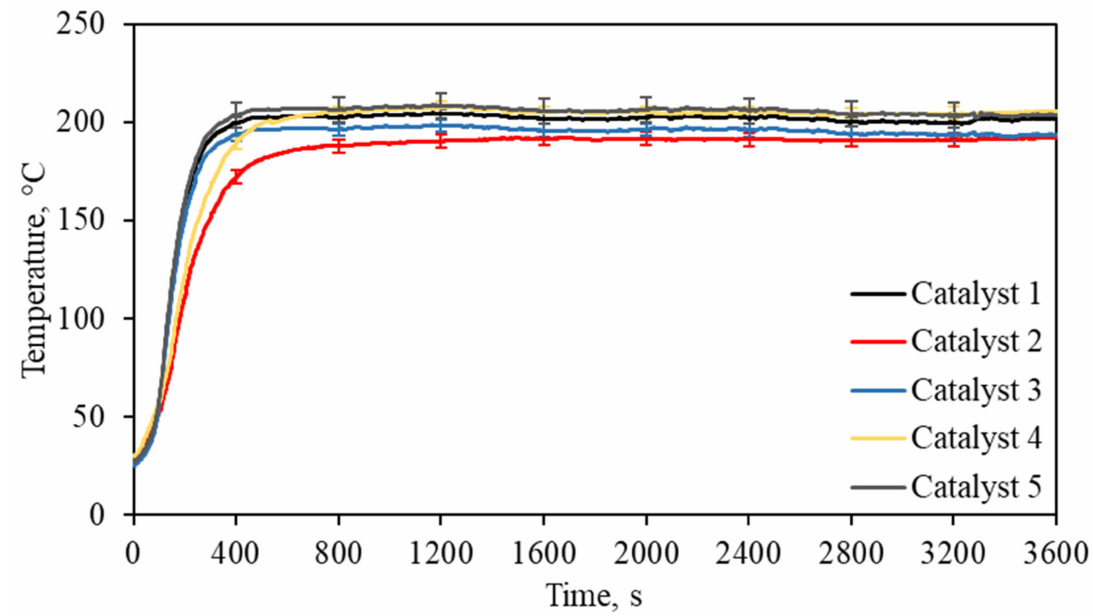
Figure 2. Combustion temperature profiles of Pt/AAO catalysts for 1 h of combustion at 3% H 2 volume fraction in